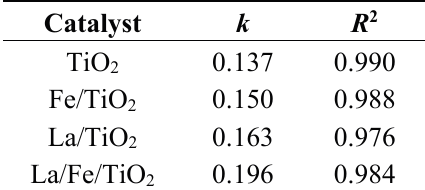
Figure 4. The curves of photocatalysis of NH 4+ -N at different conditions. Table 1. Reaction kinetics constant of